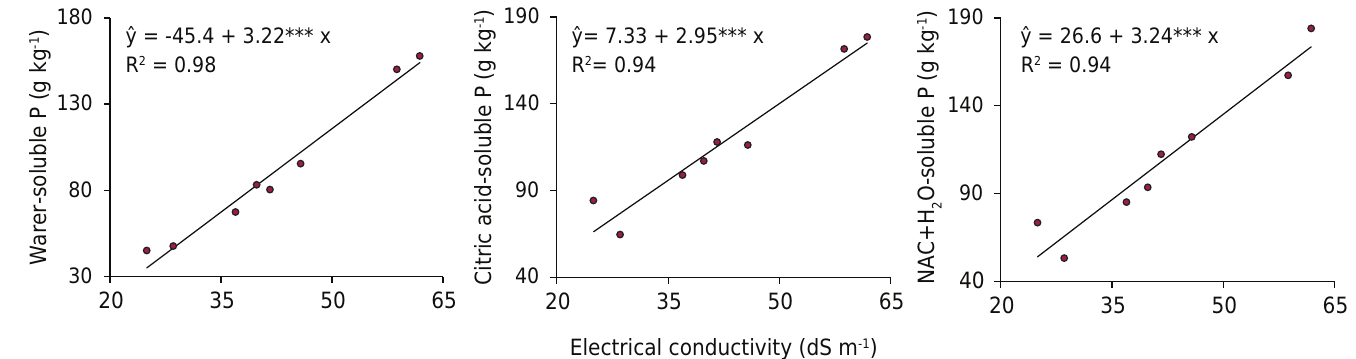
Figure 7. Contents of P soluble in water, in citric acid, and in neutral ammonium citrate plus water (NAC+H 2 O) as related to electrical conductivity of different mixtures, composted or not, of chicken manure, coffee husk, and monoammonium phosphate (MAP). *** : significant at 0.01 %